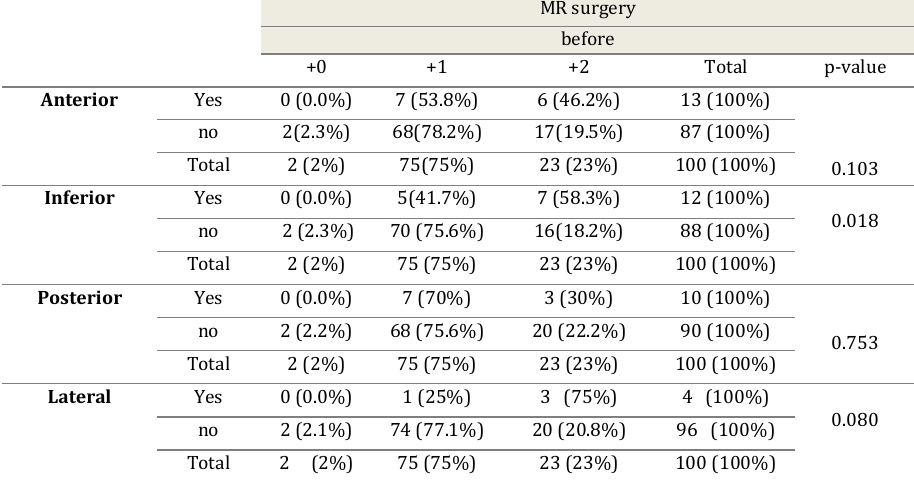
Table 2: Changes of moderate mitral regurgitation (MR) according to wall motion abnormality